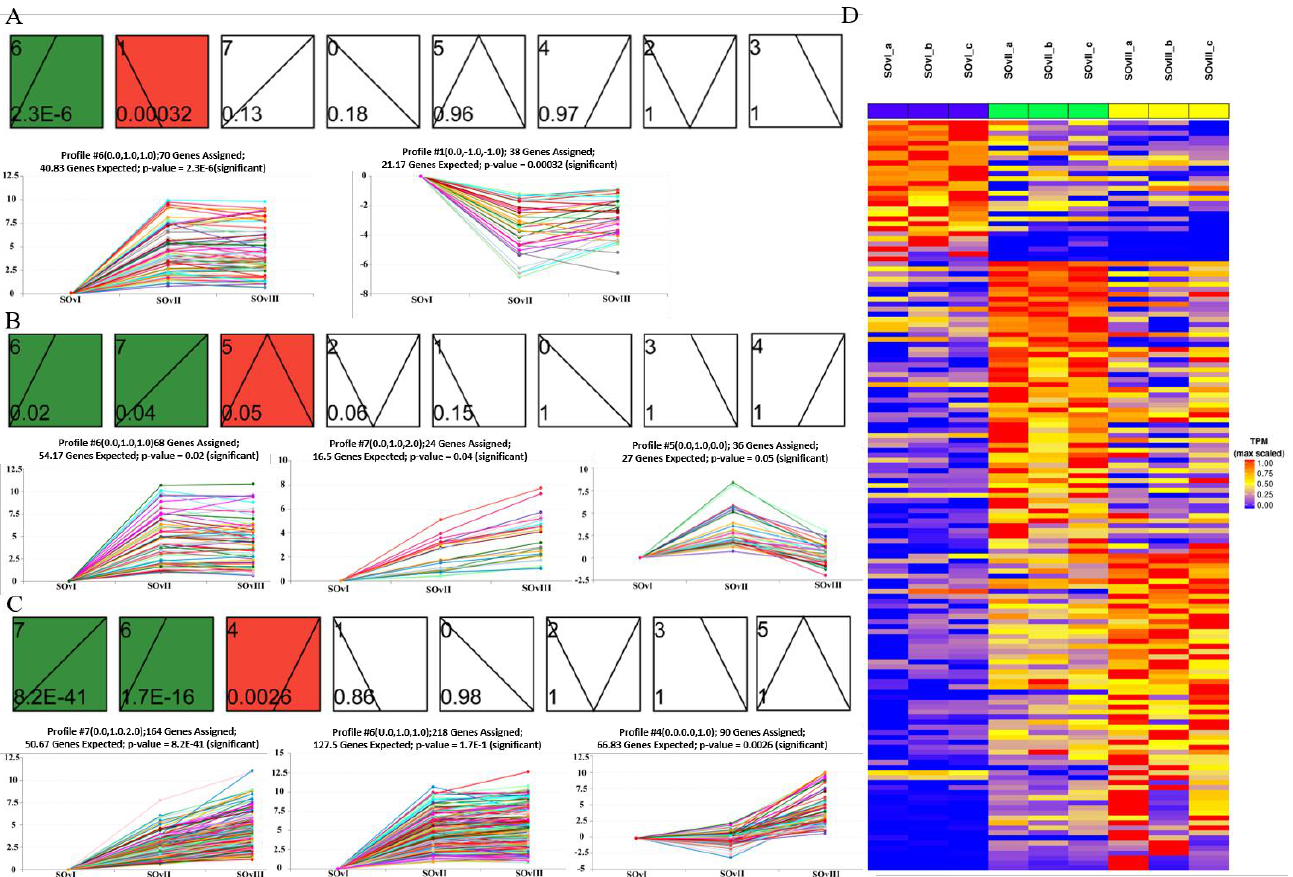
Figure 7. STEM analysis to assess temporal expression trend of DEGs in the ovary at different timepoints. ( A ) Two, ( B ) three, and ( C ) three temporal expression profiles of DEGs from OvI_vs_SOvI , OvII_vs_SOvII , and OvIII_vs_SOvIII , respectively. ( D ) Heatmap of DEGs from different groups of ovaries.